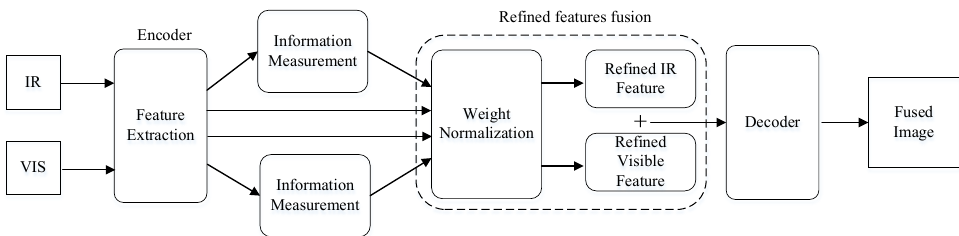
Figure 2. Pipeline of the proposed method in the testing process.